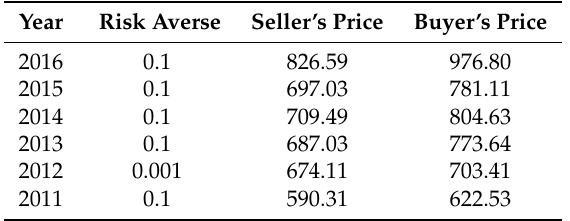
Table 1. Utility indifference prices for basket weather